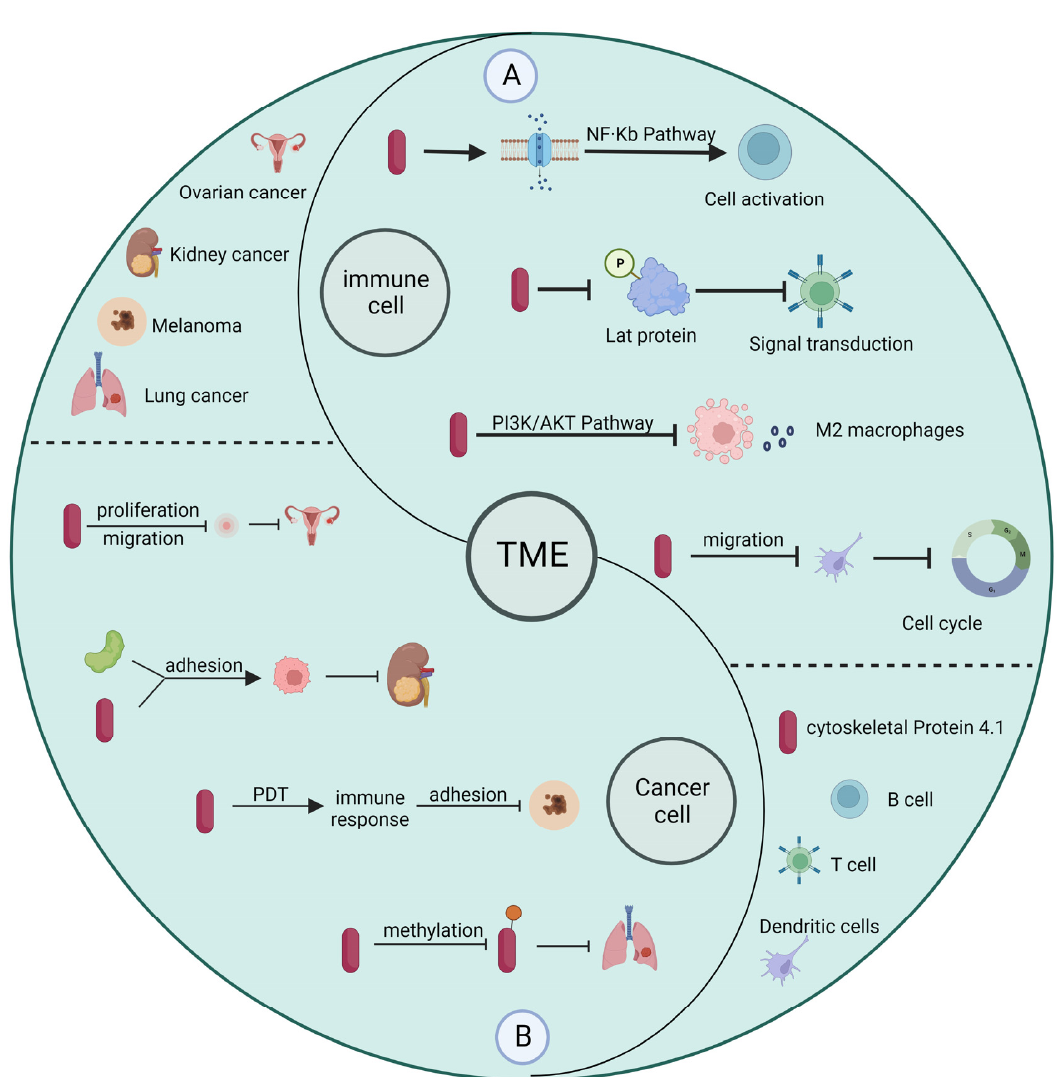
Figure 3. Relationship between cytoskeleton protein 4.1 in tumor microenvironment and immune cells and tumor cells. ( A ) In immune cells, cytoskeleton protein 4.1 affects cell activation, signal transduction, and cell cycle, among others. ( B ) In cancer cells, cytoskeleton protein 4.1 influences the progression of cancer by affecting the malignant characteristics of tumor cells.